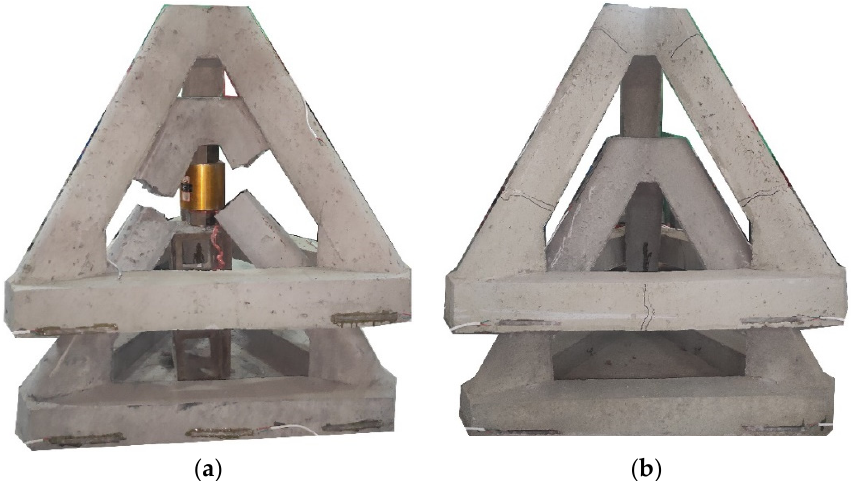
Figure 8. Status of pervious frames after loading test: ( a ) Broken of inclined rods in lifting test; ( b ) Cracking of rods in stacking test. ( b ) Cracking of rods in stacking